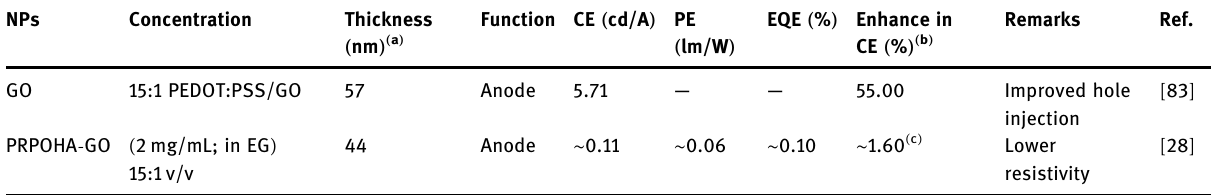
Table 3: Device characteristics of OLEDs with carbon - based NPs - doped PEDOT:PSS NPs